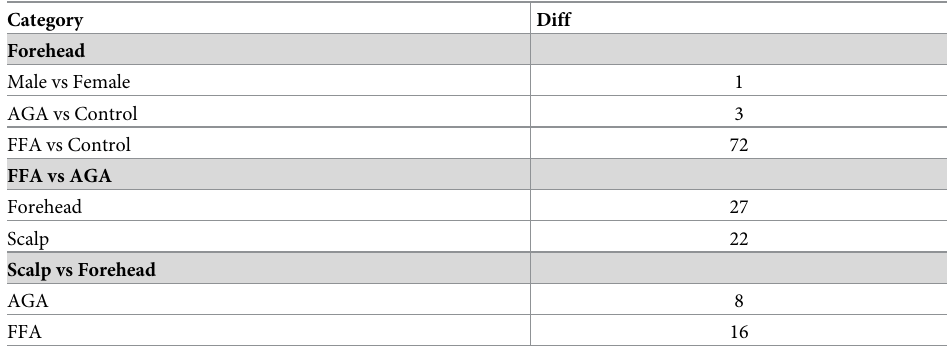
Table 1. Pairwise comparisons of protein expression